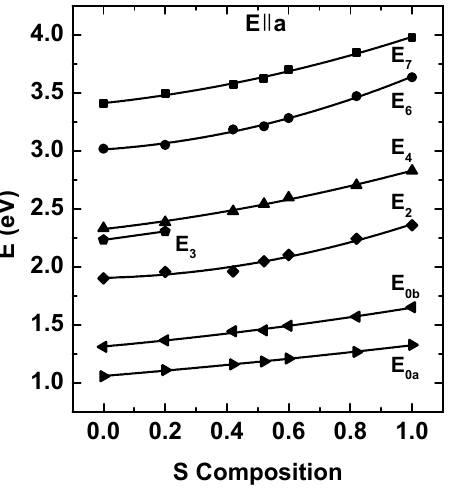
Figure 12. CP energies determined experimentally (dots). The lines are the best fits to E ( x ) = ax 2 + bx + c for the zigzag direction.